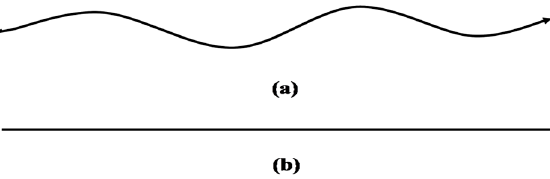
Figure 8. Travel trajectories of the solute particles for ( a ) varying aperture distribution and ( b ) consistent aperture distribution.